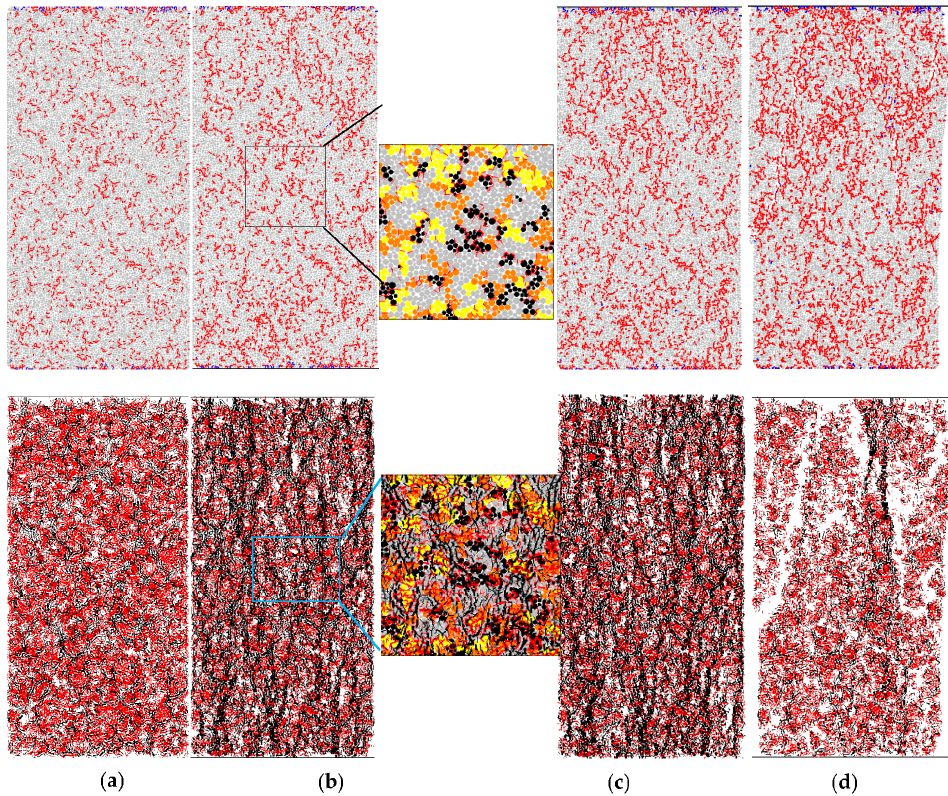
Figure 10. Crack evolution process and parallel bond force field of the granite specimen at 1000 °C ( a ) ε 1 = 3.39 × 10 − 3 , σ 1 = 8.44 MPa; ( b ) ε 1 = 1.88 × 10 − 2 , σ 1 = 71.87 MPa; ( c ) ε 1 = 2.10 × 10 − 2 , σ 1 = 75.31 MPa; and ( d ) ε 1 = 2.58 × 10 − 2 , σ 1 = 11.93 MPa.